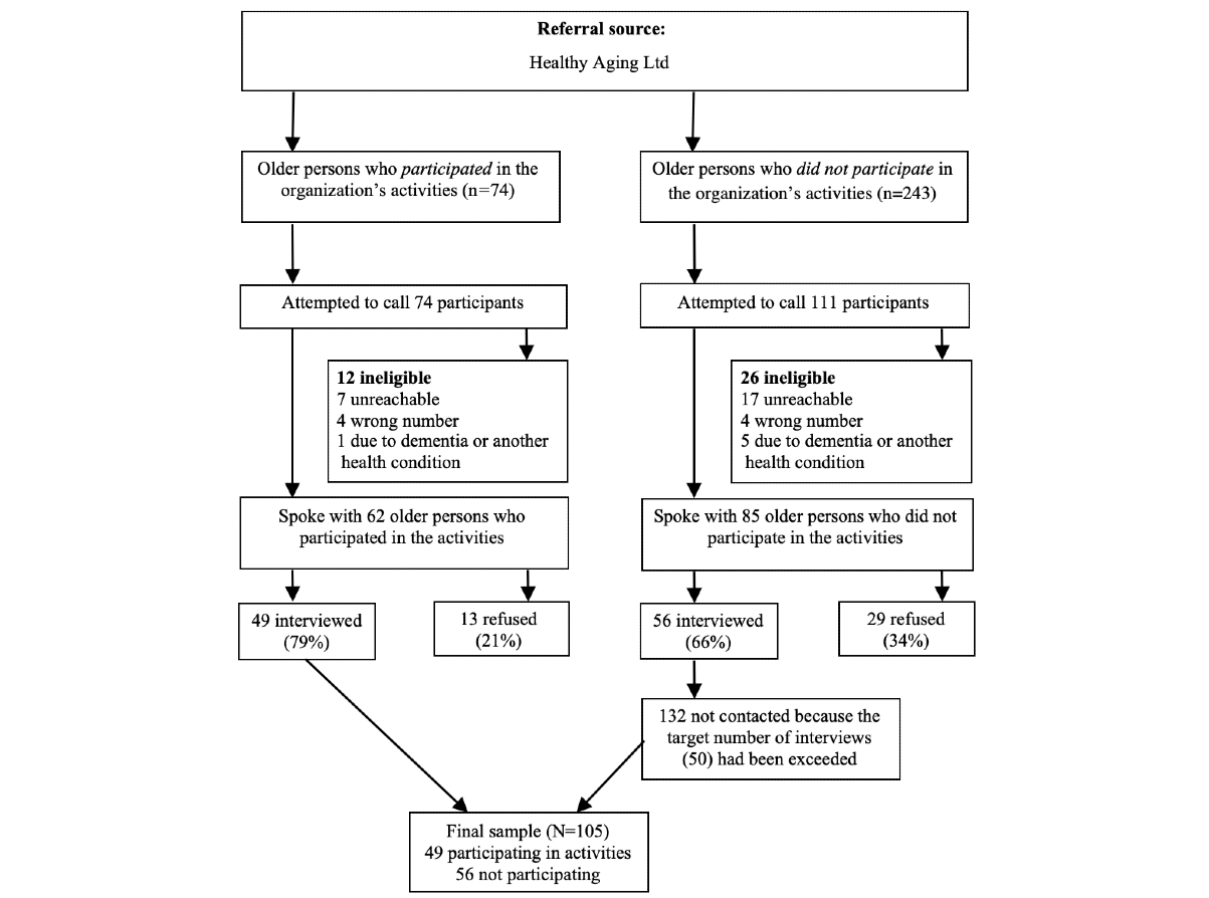
Figure 1. Participant recruitment process for the